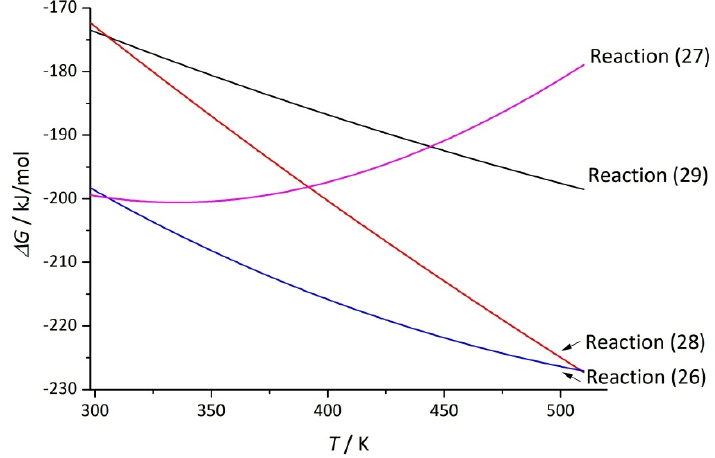
Figure 5. Temperature dependences of the change in the Gibbs energy in rutile dissolution reactions in 85% sulfuric acid, with NaF as the activator reagent. Each curve corresponds to the individual reaction.